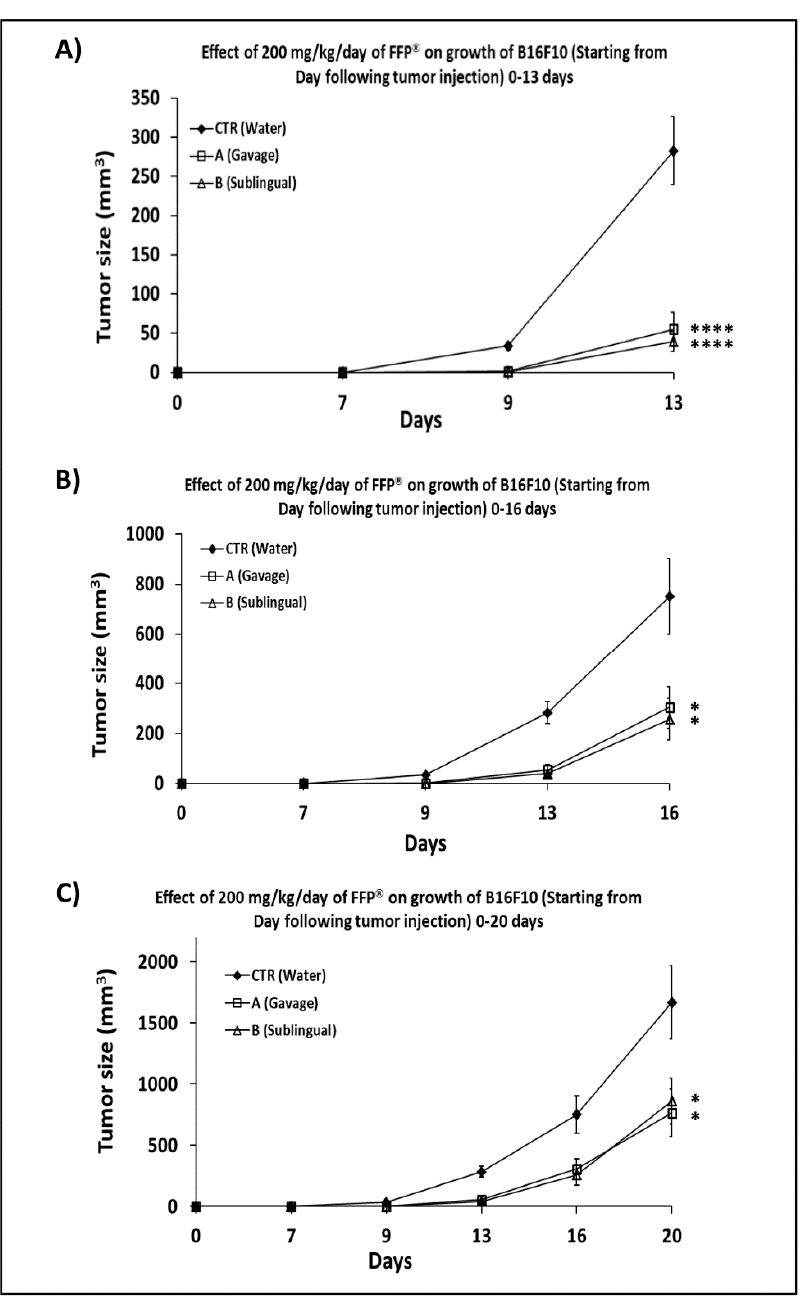
Figure 3. Effect of 200 mg/Kg/day of FPP ® on growth of B16F10 in C57/BL mice through oral gavage and sublingual administration. Effect of 200 mg/Kg/day of FPP ® on growth of B16F10 in C57/BL mice inoculated with 200,000 B16F10 cells and treated starting 7 days after cell inoculation every day without interruption with FPP ® at the concentration of 200 mg/Kg/mouse by oral gavage (group A) and sublingual (group B). Mice were divided into three groups of six animals (control, A, B) and FPP ® was performed until animal sacrifice after 20 days from the inoculation of the cells. ( A ) Effect of 200 mg/Kg/day of FPP ® on growth of B16F10 in C57/BL mice until 13 days after inoculation of cells. ( B ) Effect of 200 mg/Kg/day of FPP ® on growth of B16F10 in C57/BL mice until 16 days after inoculation of cells. ( C ) Effect of 200 mg/Kg/day of FPP ® on growth of B16F10 in C57/BL mice until 20 days after inoculation of cells (animal sacrifice). Data are expressed as means ± SE. * p < 0.05, **** p < 0.0001.